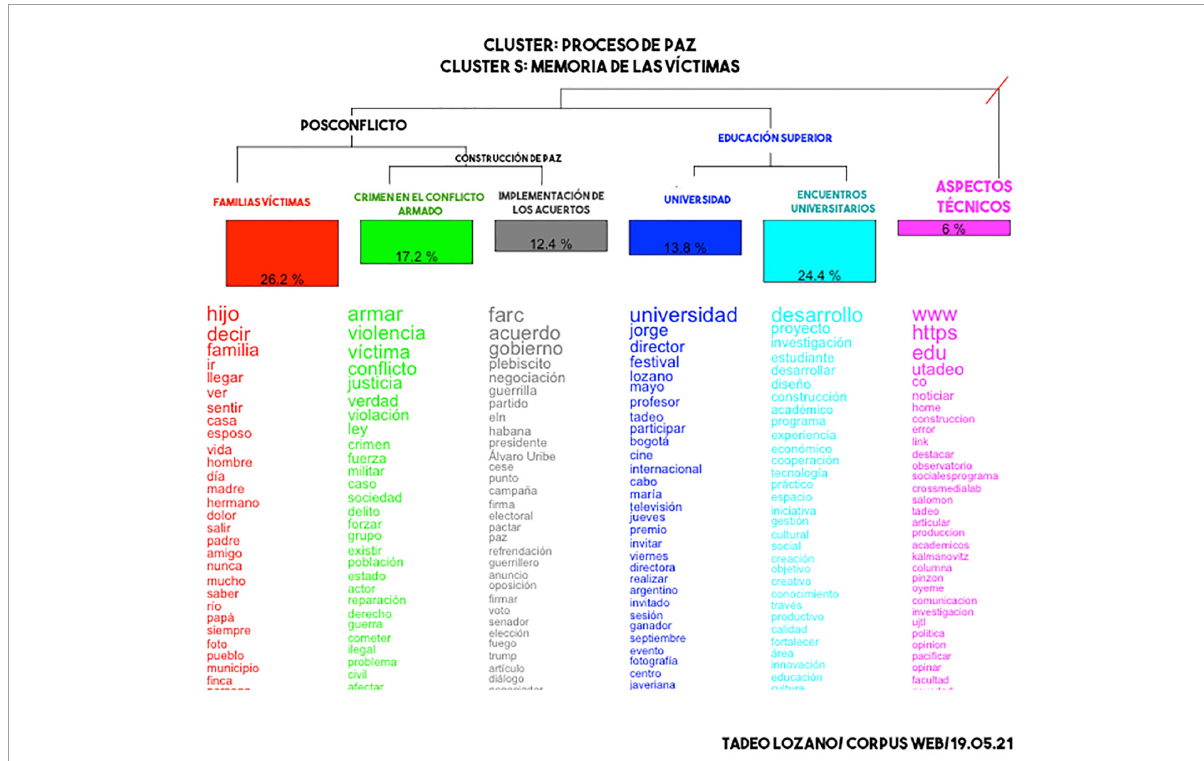
FIGURE1 Cluster linkage by dendrograms. Processing of lexical worlds from Iramuteq. The cluster “Peace Process” is exemplified, a similar process was followed for “Memory of Victims” and “Armed Conflict.” Source: RUTAS Project.